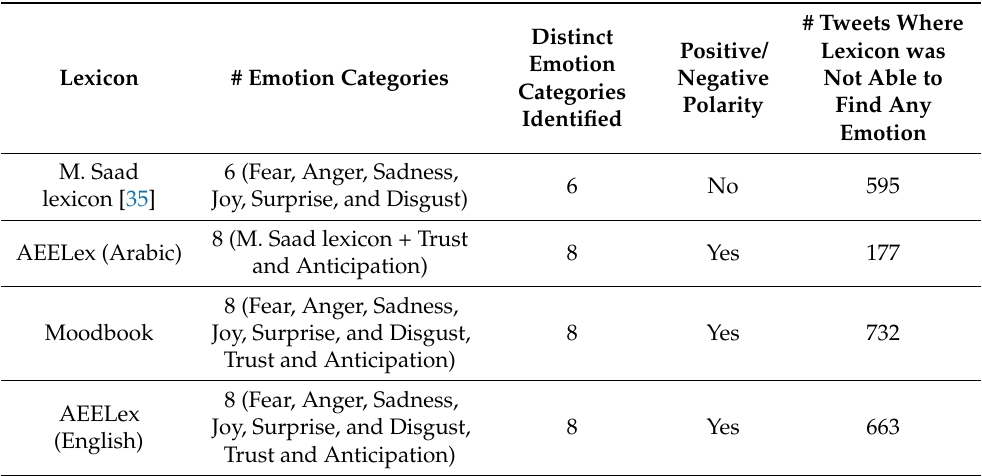
Table 6. Comparison of AEELex with other